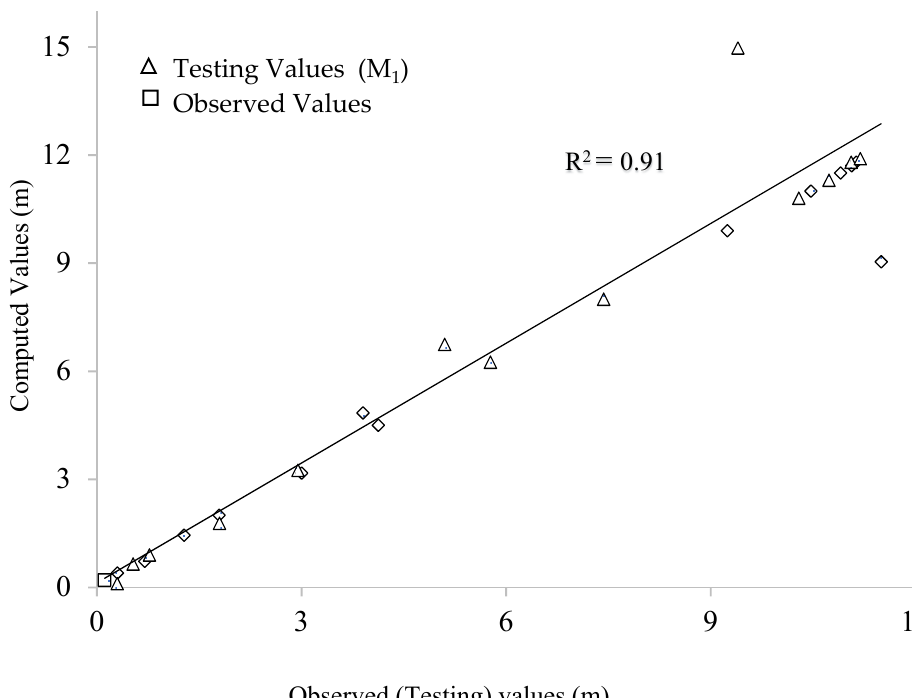
Figure 10. Plot between observed and computed shock wave height.